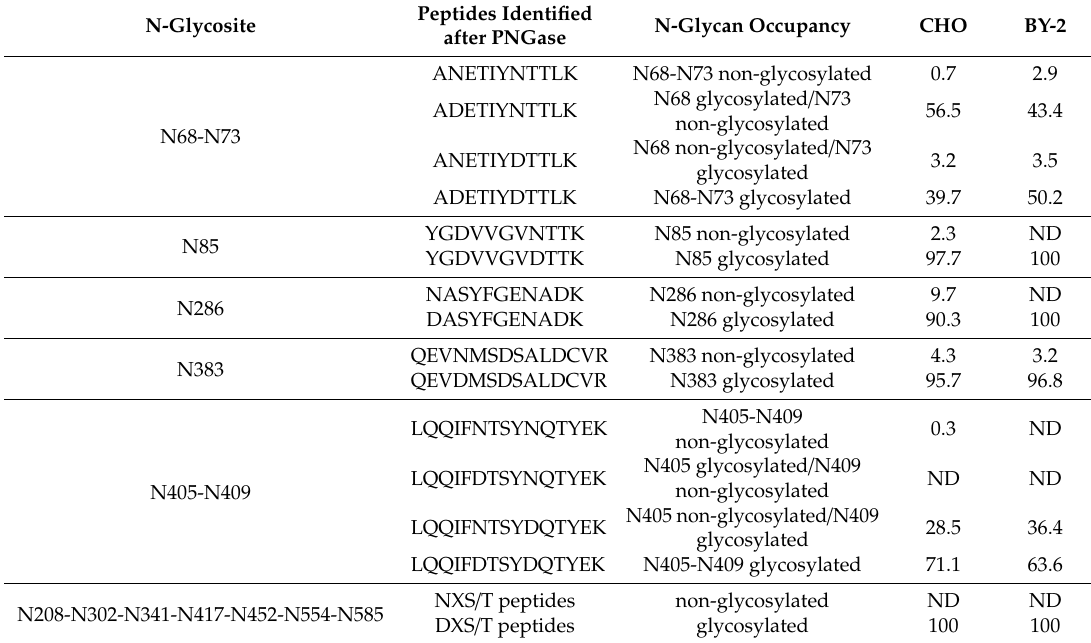
Table 1. N-Glycosylation site occupancy of gB produced in CHO and BY-2. N-glycosylation site occupancy (%) was deduced from the ratio of deamidated to unmodified peptide upon N-glycan release with PNGase F (CHO) or PNGase A (BY-2). ND: not detected. Peptides Identified N-Glycosite after